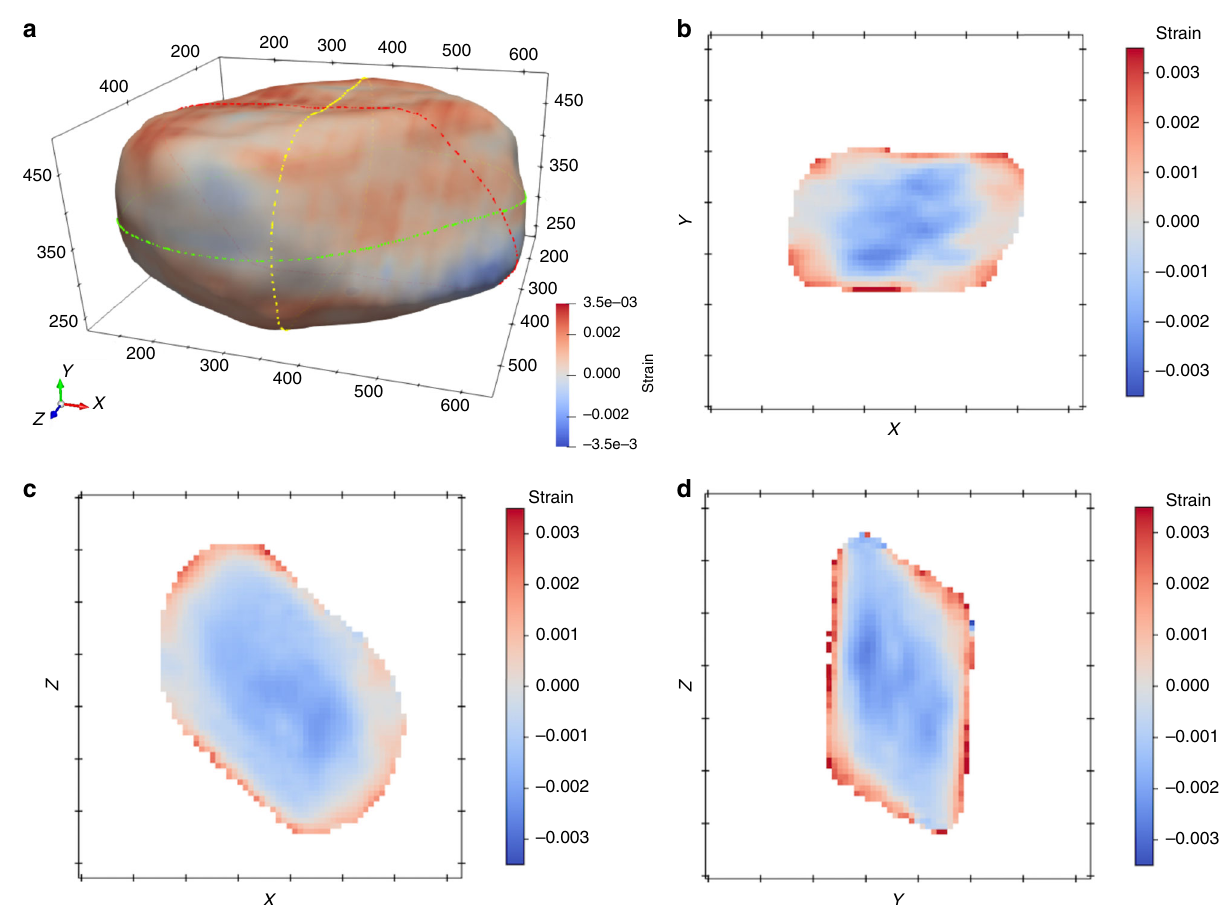
Fig. 5 Bragg coherent diffractive imaging reveals the internal structure of a single crystallite from the L1.28 cathode after 1-year cycling. a Three- dimensional render of the crystallite, where the color map denotes strain and corresponding cross sections through the 3D structure in the b XY, c XZ, and d YZ planes. Tick spacings along all axes correspond to 100